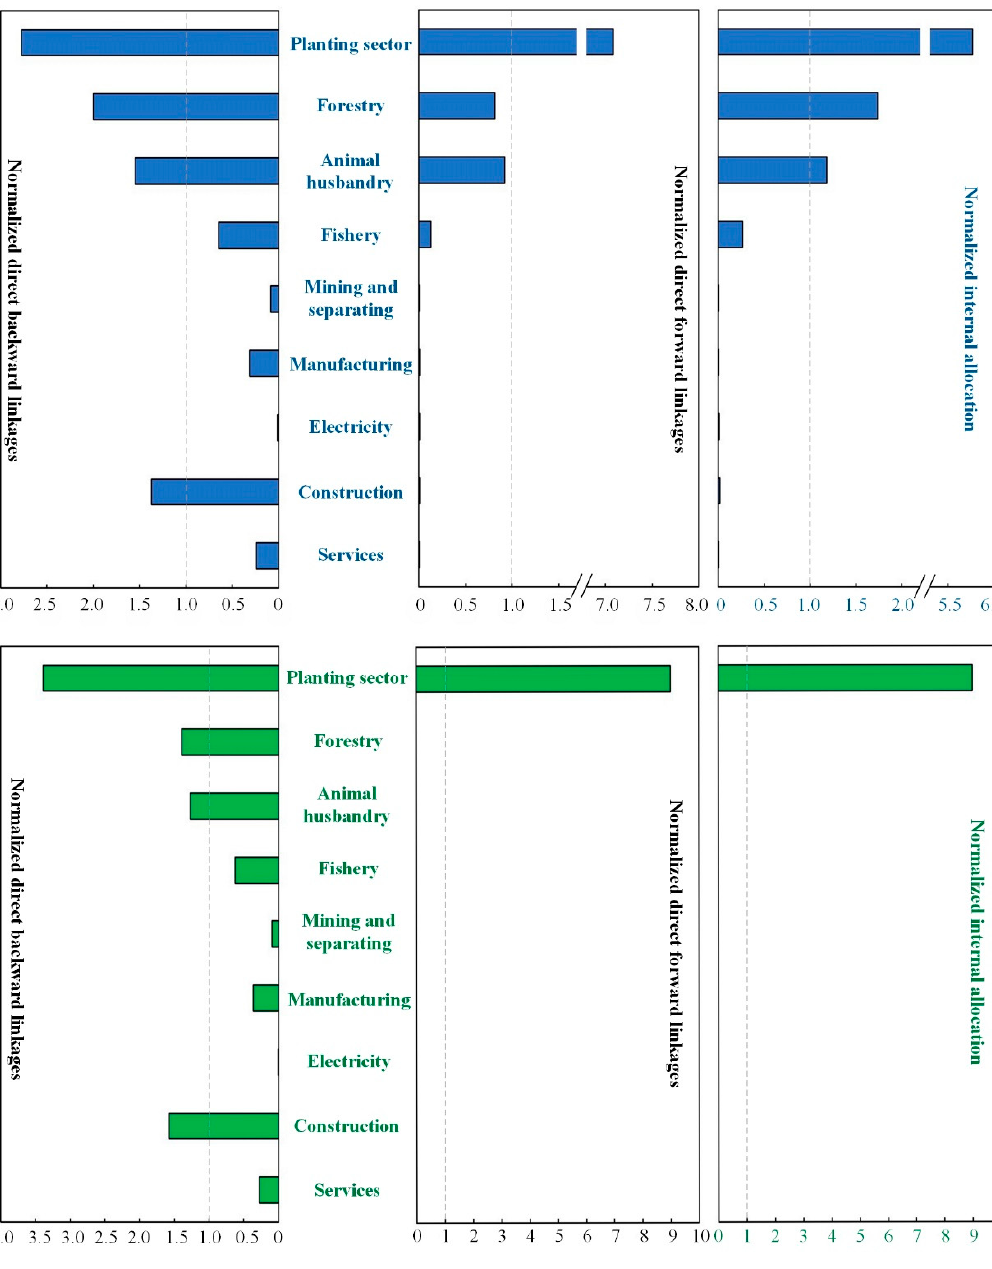
Figure 4. Normalized backward and forward linkages and internal allocation of economic sectors.